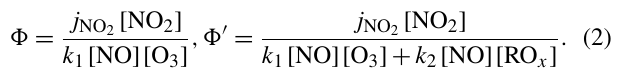
Figure 7. Correlation between photochemical production and NO x improved after including the additional 15 RLO flights. The corre- lation suggests that the flight region is in the NO x -limited